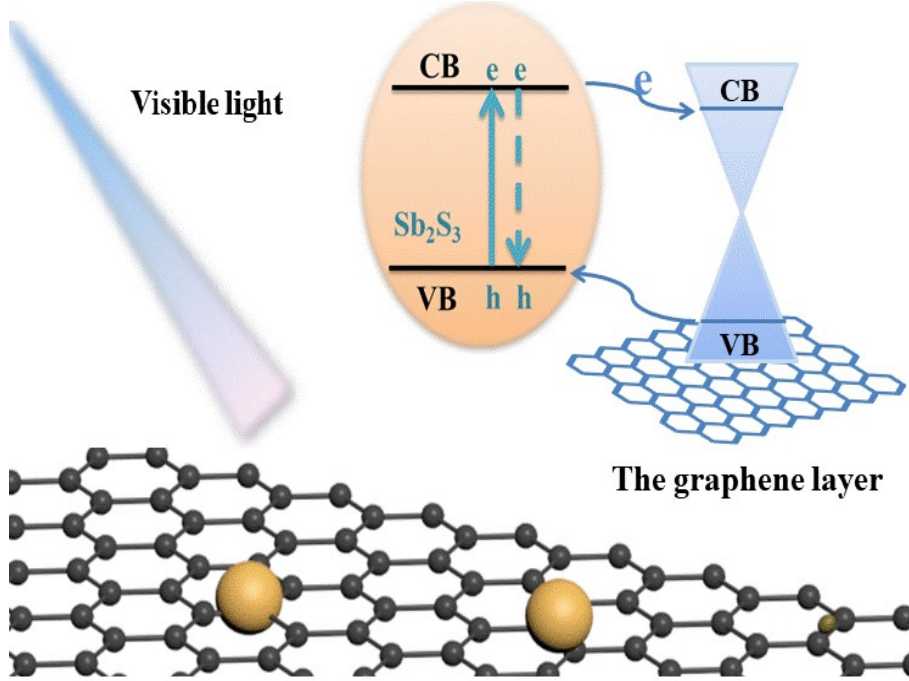
Figure 8. Charge-transfer mechanism of the Sb 2 S 3 /RGO composites.